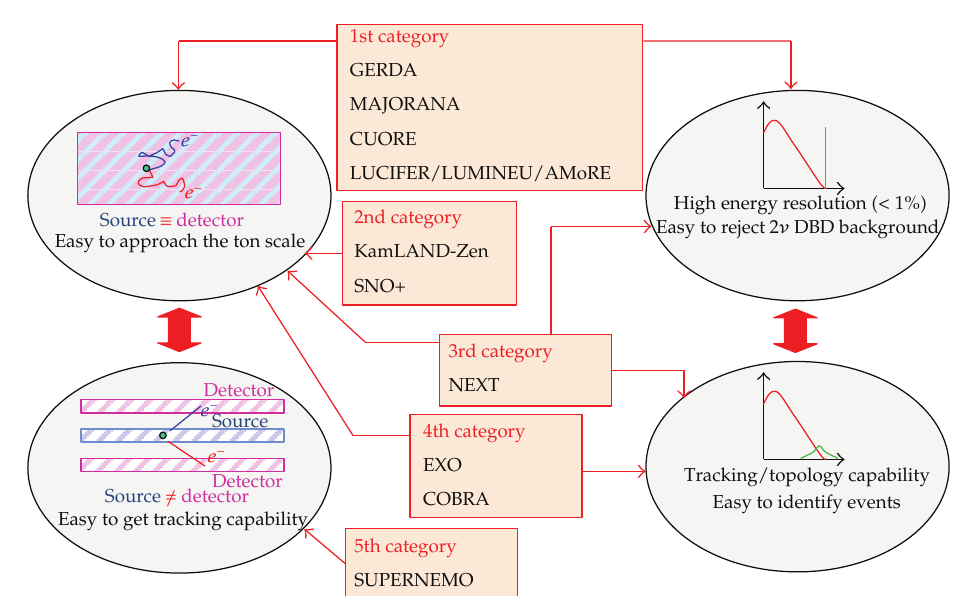
Figure 11: Experiments reviewed in the text are divided into five categories, according to the experimental approach and the main features of the detector performance. Running experiments are written in boldface